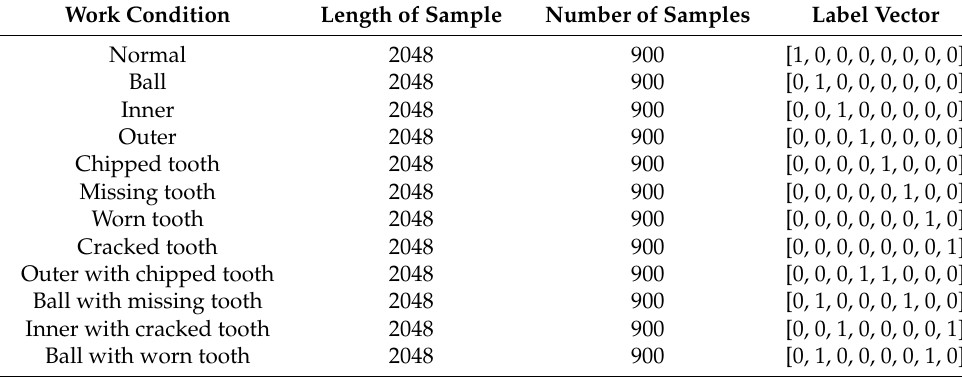
Figure 11. Time domain diagram of the vibration signal. Table 2. Experimental samples and labels.